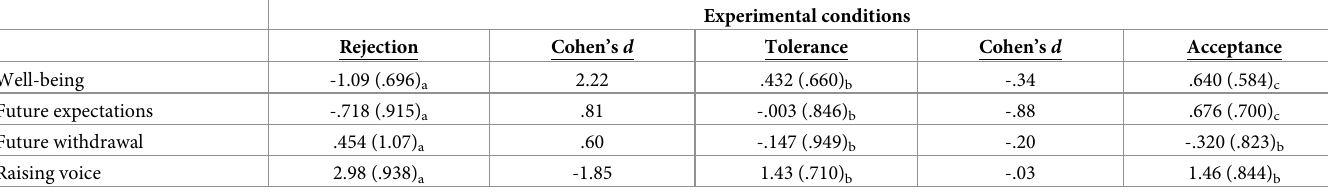
Table 7. Key outcome variable contrasts for Study